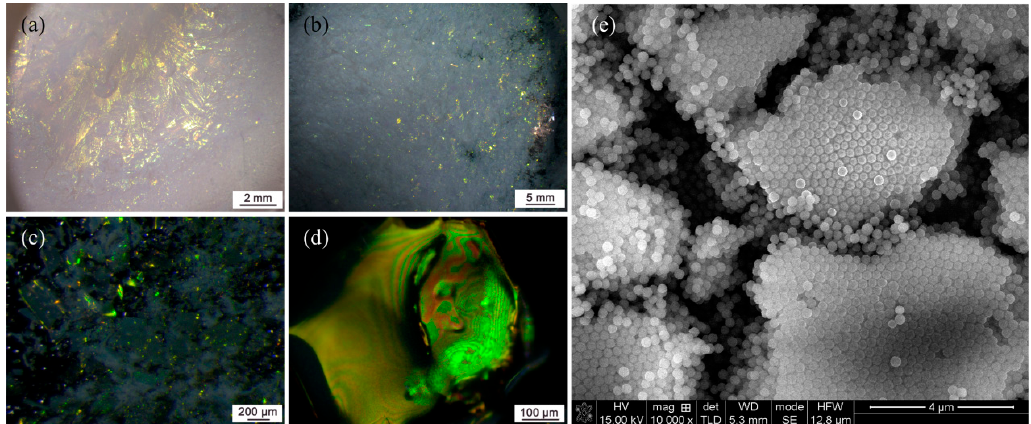
Figure 2. Photographs of the product: ( a – d ) microscopic photographs with different magnifications under white illumination; and ( e ) scanning electron microscope (SEM) photographs.